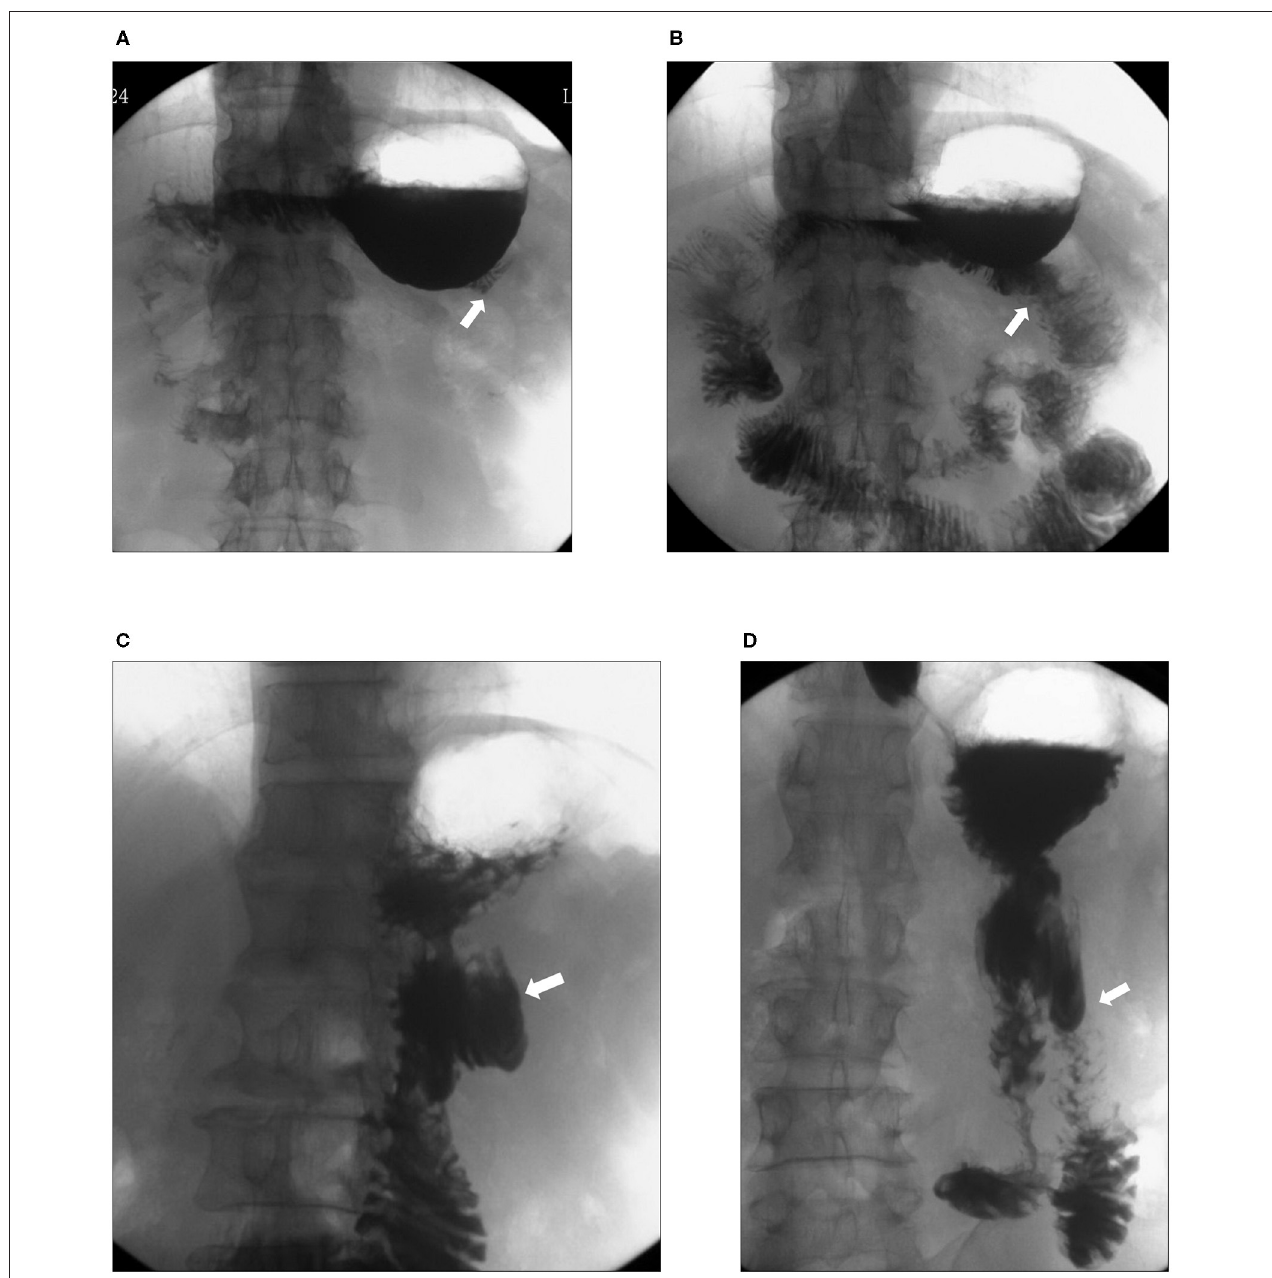
FIGURE 3 | Upper gastrointestinal radiography of patients with recanalization. Upper gastrointestinal radiography showed closure of the afferent limb (white arrows) 1 month after the operation (A) and recanalization (white arrow) 3 months after the operation (B) . In another patient, upper gastrointestinal radiography showed closure of the afferent limb (white arrow) 3 months (C) after the operation and recanalization (white arrow) 6 months after the operation (D) .